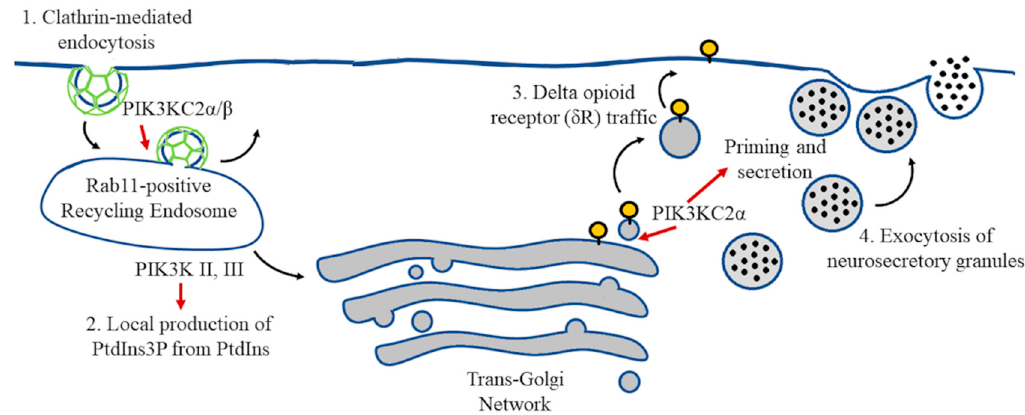
Figure 3. PIK3KC2 α and β are associated with clathrin-coated endocytic intermediates (1.) while PIK3K II and III participate in the local production of PtdIns3P at recycling endosomes (2.). PI3KC2 α regulates priming and secretion of large dense core vesicles at chromaffin cells (3.) and PI3KC2 α is required for Delta opioid receptor ( δ R) trafficking [4].